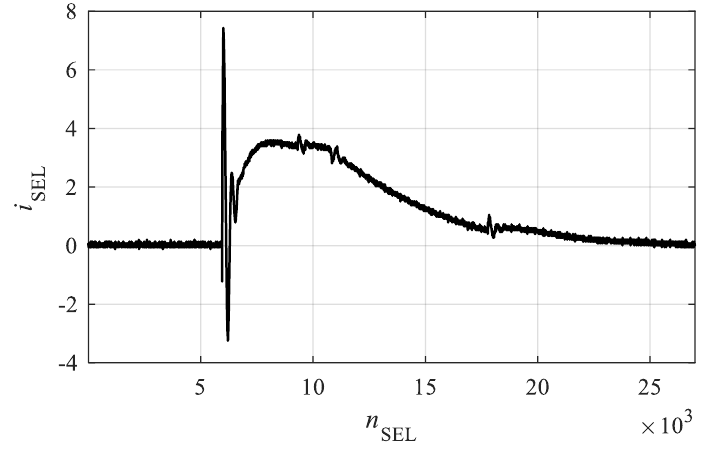
Figure 6. Current vector